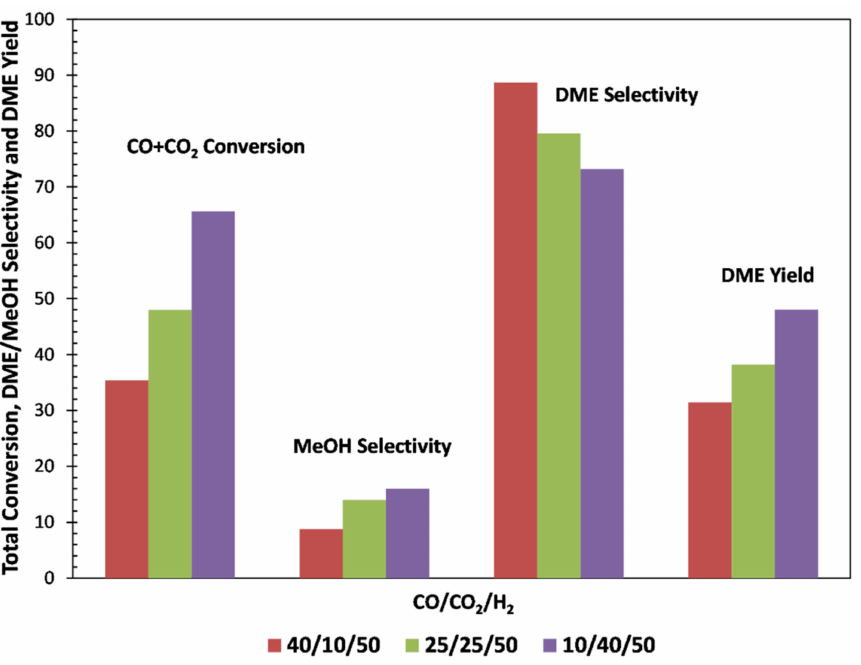
Figure 11. Total conversion, DME/MeOH selectivity, and DME yield of 25STA@CZA-MA catalysts at different feed composition (T = 275 ◦ C; P = 50 bar; space-time of 0.72